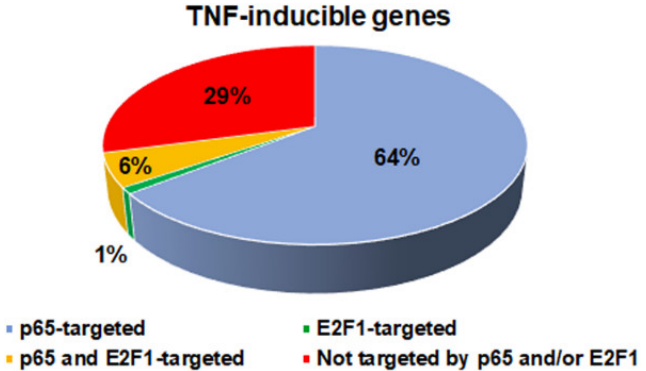
Figure 4. The percentage of TNF α -inducible genes in HeLa cells targeted by p65 alone or by